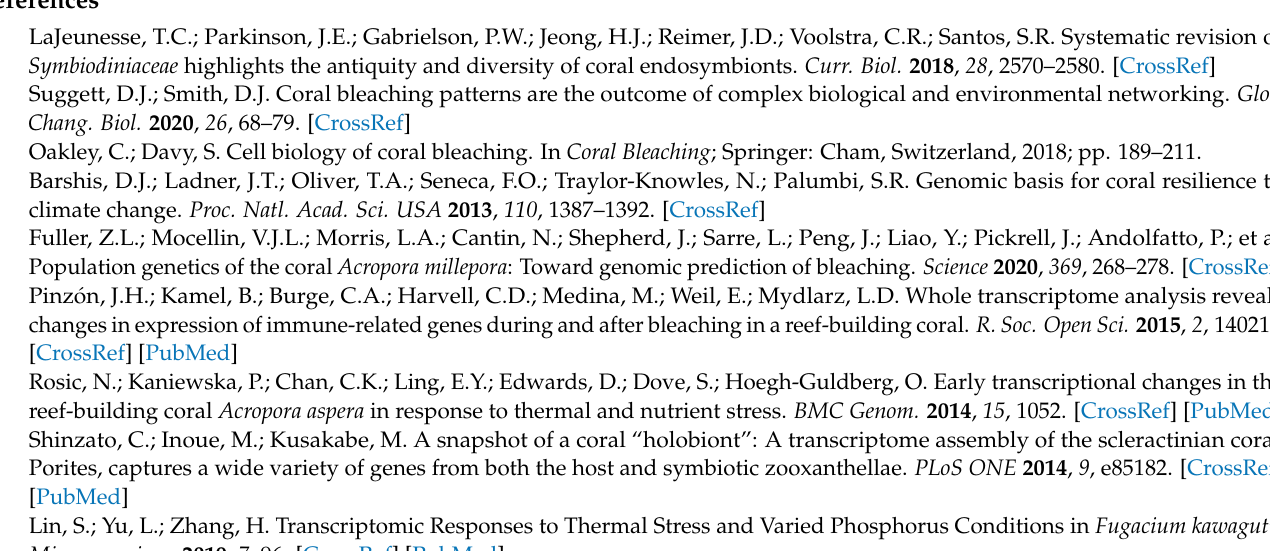
tested methods, Figure S3: Time courses of cell density of Symbiodinium tridacnidorum cultures (A) and peridinin- chlorophyll - protein complex (PCP) accumulation (B) in cultures grown under varying light conditions. Before being transferred to 30 µ mol m − 2 s − 1 (low light, LL), cultures were developed under 120 µ mol m − 2 s − 1 (control). Light shift was performed at the late exponential phase (day 14) for 7 days; Figure S4: Gene ontology (GO) assignment involve in biological (A), molecular (B) and cellular (C) functions for differentially expressed proteins (DEPs) identified in Symbiodinium tridacnidorum cultures grown under control (120 µ mol photon m − 2 s − 1 ) and low light (30 µ mol photon m − 2 s − 1 ) stress condition for 7 days from three biological replicates ( n = 3), Table S1: Gene ontology (GO) assignment involve in biological, molecular and cellular functions with GO count for the proteins identified in filter-aided sample preparation (FASP), single-pot solid- phase-enhanced sample preparation (SP3), and stop-and-go-extraction tips (STAGETips, ST) based protein sample preparation workflows in Symbiodinium tridacnidorum , Table S2: List of differentially expressed proteins (DEPs) with their statistical scoring, protein descriptions and expression level (ratio over control values, ≥ 2 fold, p < 0.01 and 0.05) identified in Symbiodinium tridacnidorum grown under control (120 µ mol photon m − 2 s − 1 ) and low light (30 µ mol photon m − 2 s − 1 ) conditions for 7 days (three biological replicates; n = 3). Extracted proteins were processed using SP3 workflow for protein sample